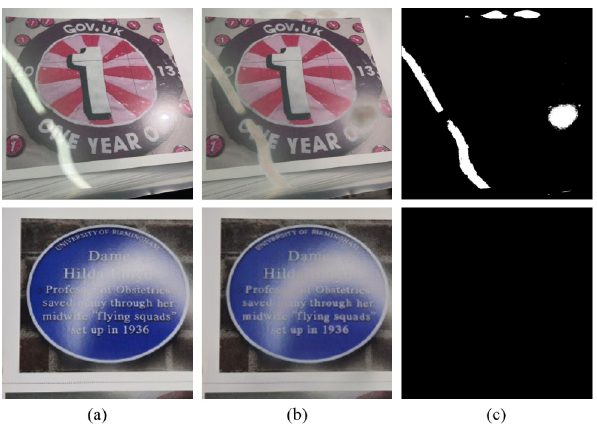
Fig. 8 Examples of failures: (a) input image, (b) our highlight removal results, and (c) our detection